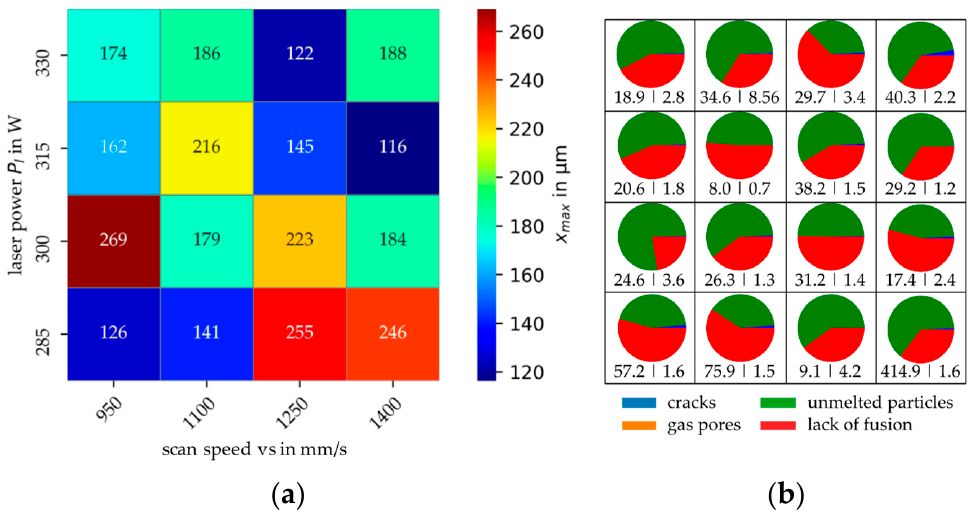
Figure 5. ( a ) Maximum pore size, ( b ) porosity fraction of each defect type and absolute porosity caused by cracks (left number) and gas pores (right number) in ppm.